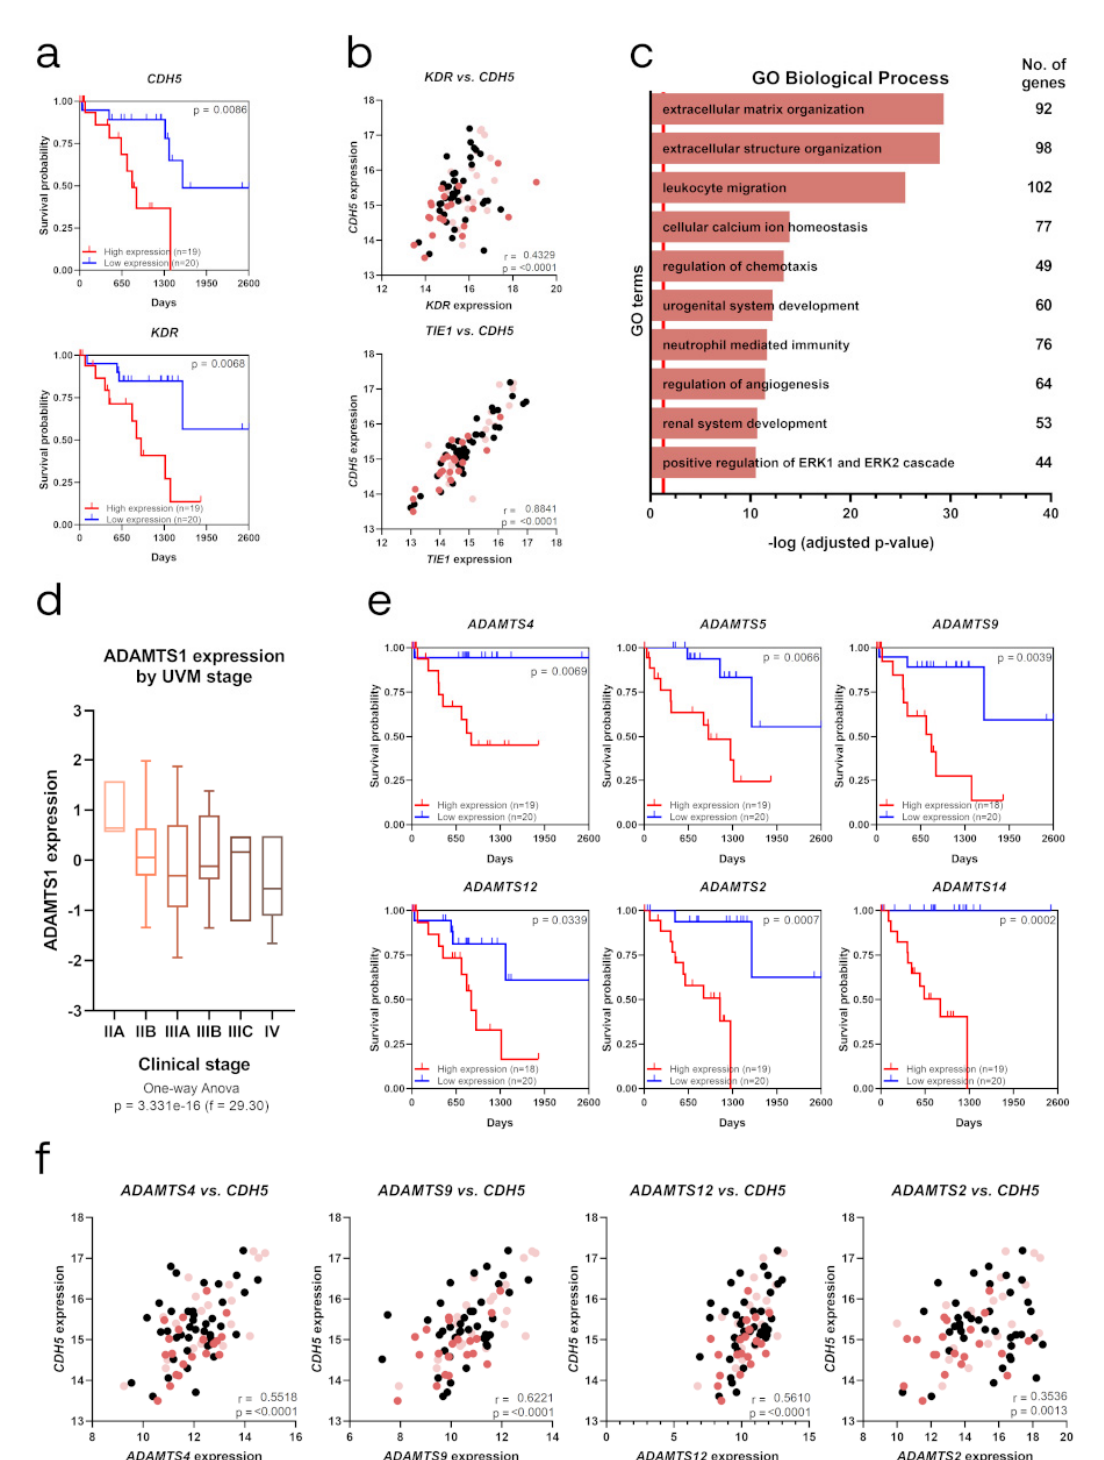
Figure 6. Identification of EL and ECM molecules as poor prognosis factors in TCGA Uveal Melanoma Project (TCGA-UVM). ( a ) Kaplan–Meier survival curves for low and high gene expression levels of EL markers CDH5 and KDR ; ( b ) Scatter plot representing Pearson correlation analysis between gene expression levels of CDH5 and endothelial-related KDR and TIE1 ; ( c ) Representation of top ten GO Biological Processes after enrichment analysis using genes that positively correlated (q-value < 0.05) with CDH5 . Red line determined the limit of significance: -log (0.05); ( d ) Box graph representing ADAMTS1 expression among different clinical stages of human uveal melanoma, from stage IIA to IV ( n = 4 for IIA, n = 32 for IIB, n = 27 for IIIA, n = 10 for IIIB, n = 3 for IIIC and n = 4 for IV); ( e ) Kaplan– Meier survival curves for low and high gene expression levels of extracellular proteases ADAMTS4,